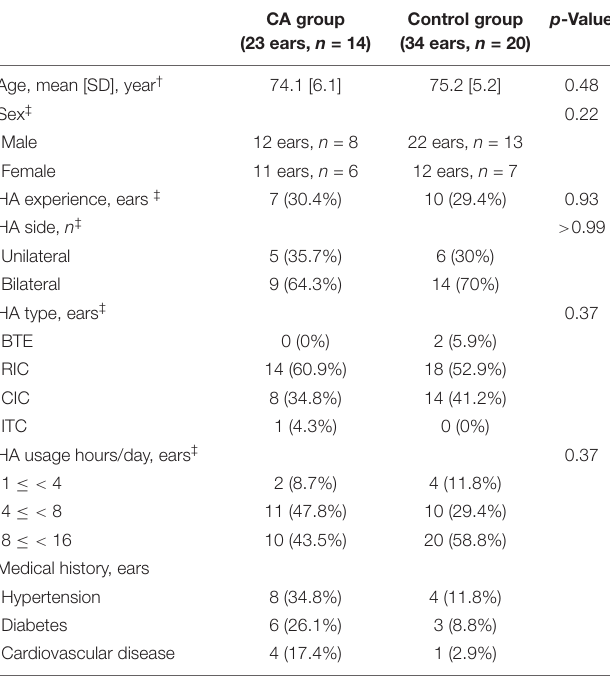
TABLE 1 | Patient